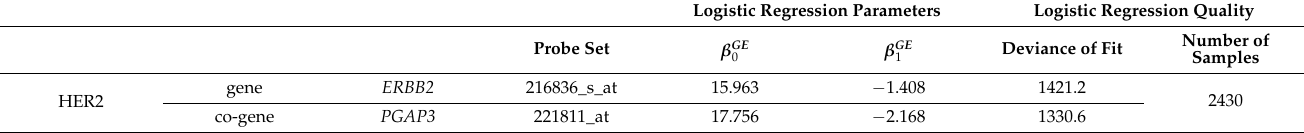
Table A2. Probe sets and logistic regression for receptor genes and co-genes. c 0 and c 1 are coefficients from logistic regression for IHC values (dependent variable) versus gene expression (independent variable) [37,58]. Probe sets refer to the Affymetrix chip U133A + 2.0. For ‘deviance of fit’, see p. 118 in McCullagh [108]. Upper limits for beliefs (ˆ α , ˆ β ) are explained in Appendices A.4 and A.5. See Equations (A1) and (A2) for computing the limits, and Equation (4) for their application. Logistic Regression Parameters Table A3. Probe sets and logistic regression for gene and co-gene of HER2. c 0 and c 1 are coefficients from logistic regression for IHC (dependent variable) versus gene expression (independent variable) [37,58]. Probe sets refer to the Affymetrix chip U133A + 2.0. For ‘deviance of fit’, see p. 118 in McCullagh [108].